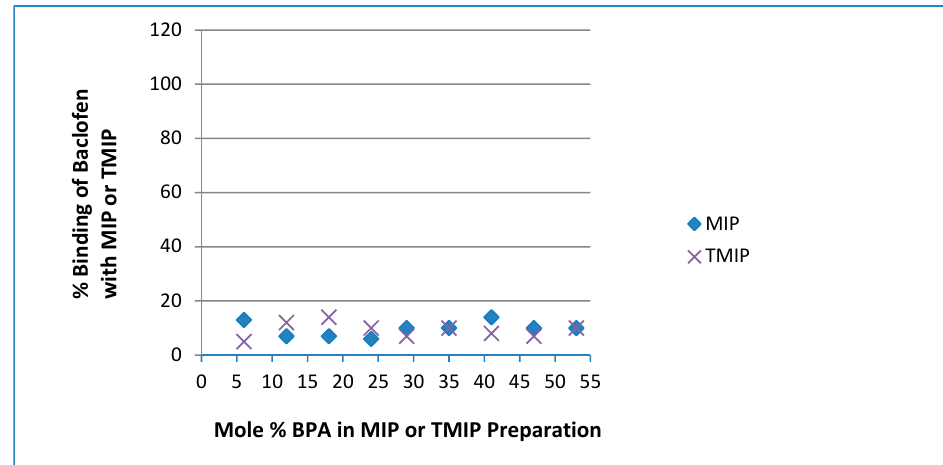
Figure 3. Percent binding results of BFN (individually) for each MIP and TMIP prepared with a different mole % BPA. For clarity, error bars are represented by the size of symbols.